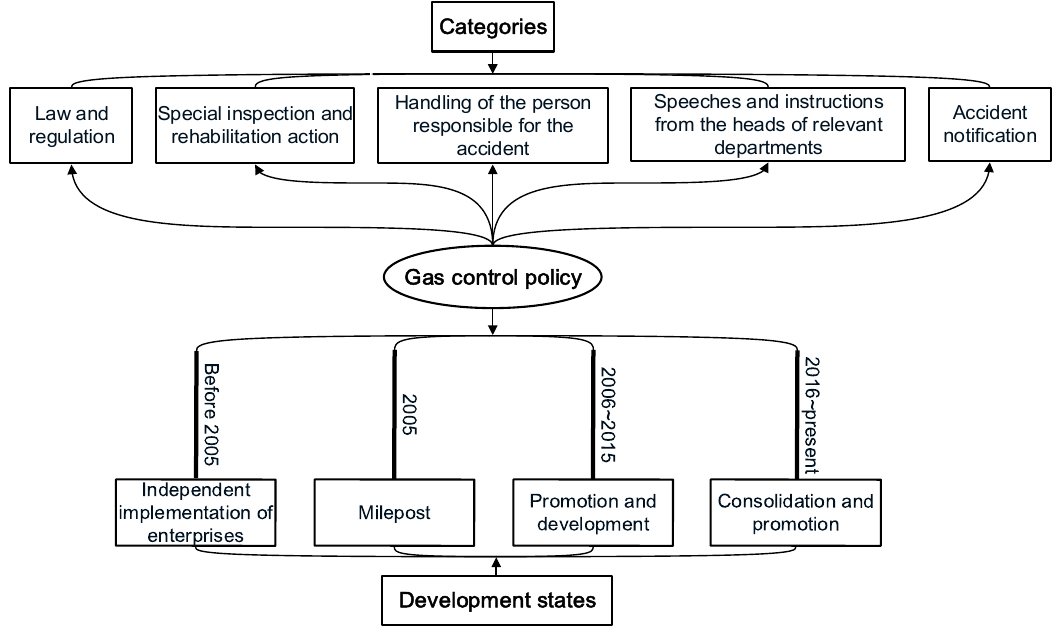
Figure 17. Classification and development stage of gas control policy.